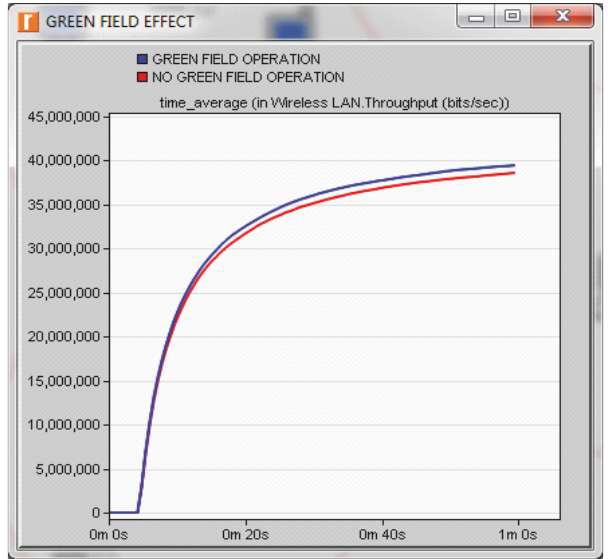
Figure 26: WLAN buffer size optimization for lower delay.